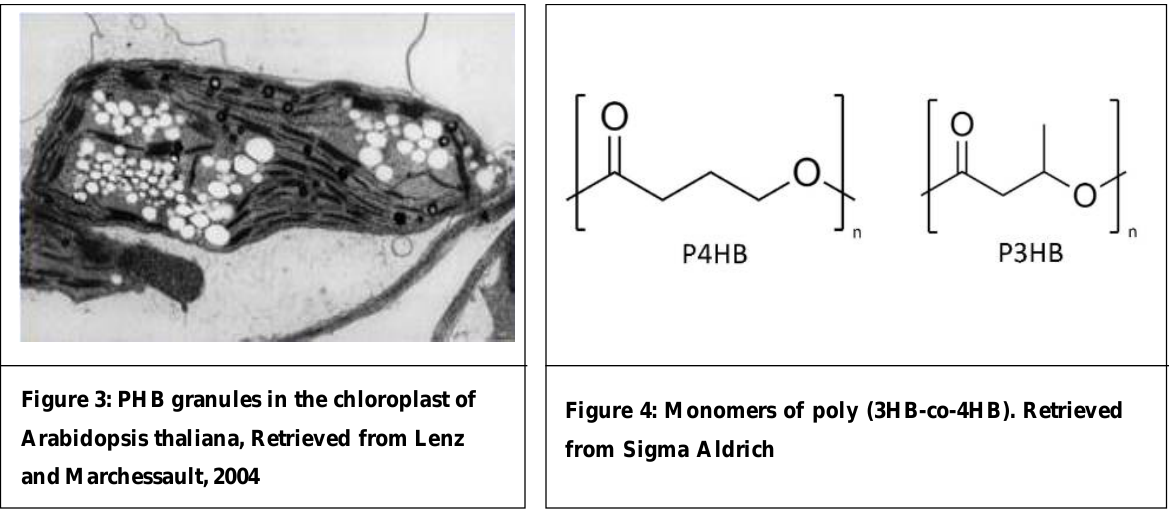
Figure 4: Monomers of poly (3HB-co-4HB). Retrieved from Sigma Aldrich